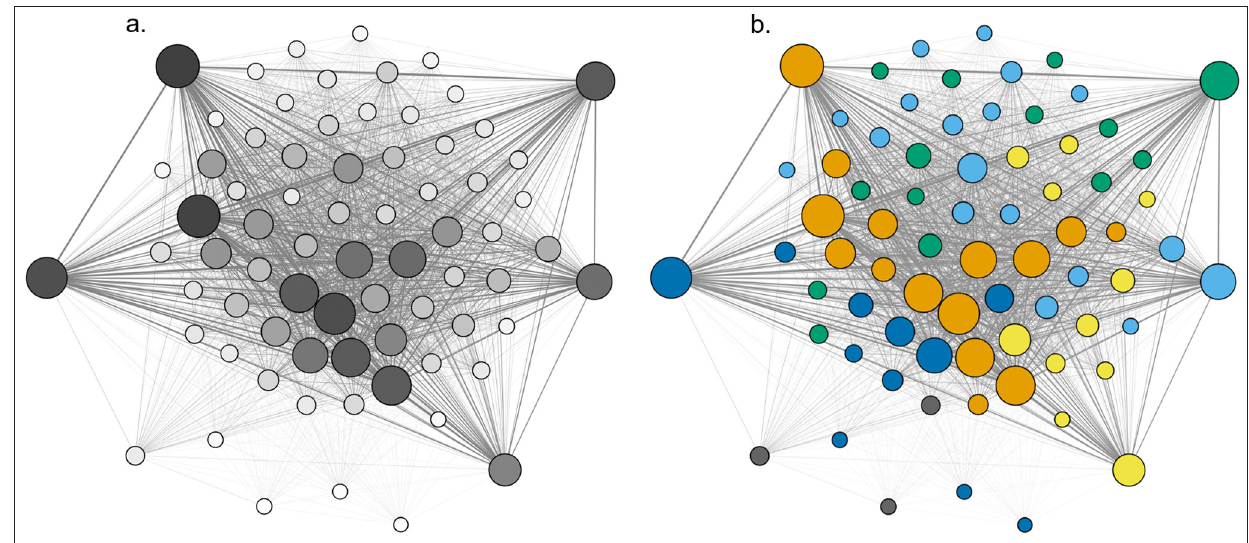
Figure 1 ( a ) Network mapping of individual codes before cluster analysis, and ( b ) codes once assigned to clusters based on the network analysis modularity technique and second-cycle theoretical coding of clusters. Color legend is as displayed in Figure